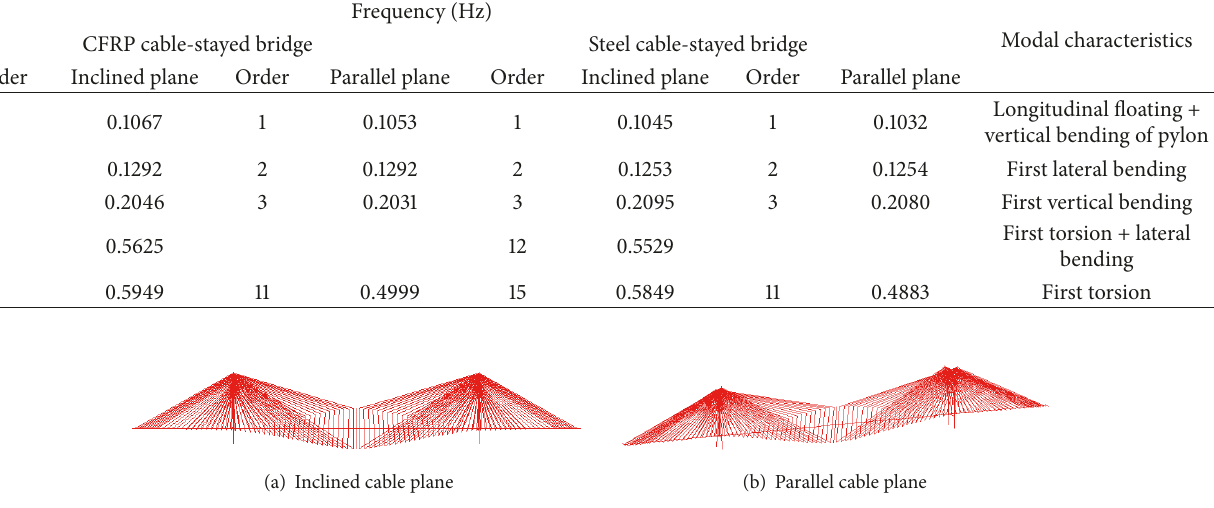
Figure 12: Torsional vibration mode of the cable-stayed bridges with different cable